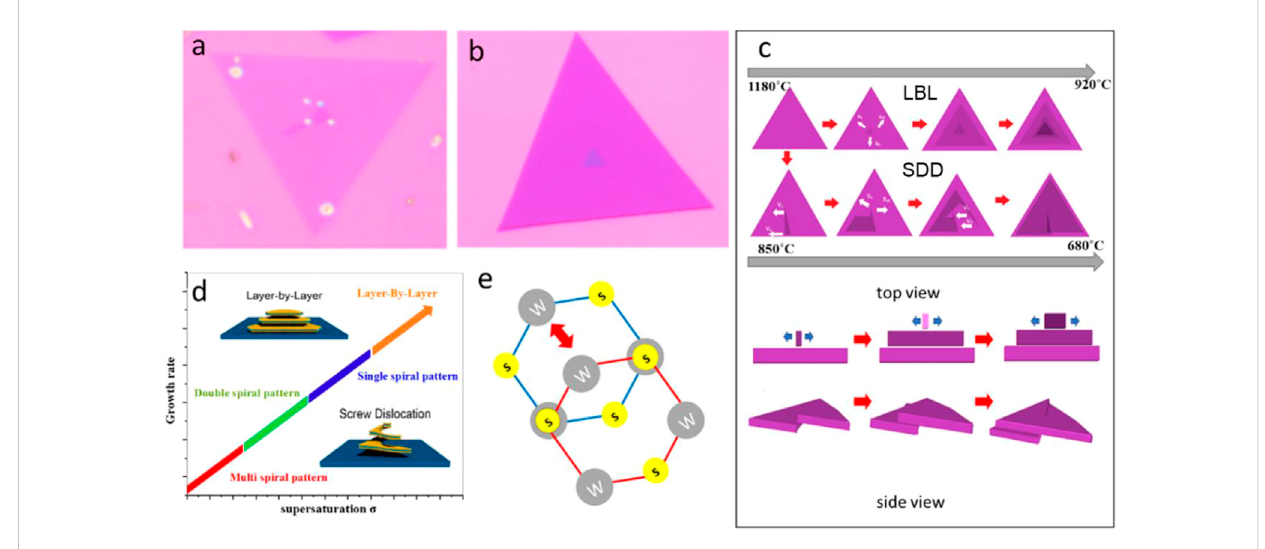
FIGURE 5 Mechanisms Formation of Layer by Layer and Dislocated WS 2 Spirals (A,B) Optical image of single spiral pattern and layer by layer WS 2, respectively. (C) Schematic diagrams of Layer-By-Layer and screw dislocation propagation process. (D) Schematic illustrations of the growth rate of different dominant crystal growth modes as a function of supersaturation. (E) The tungsten atom in the top layer (red hexagon) positioned at the center of the bottom layer hexagon